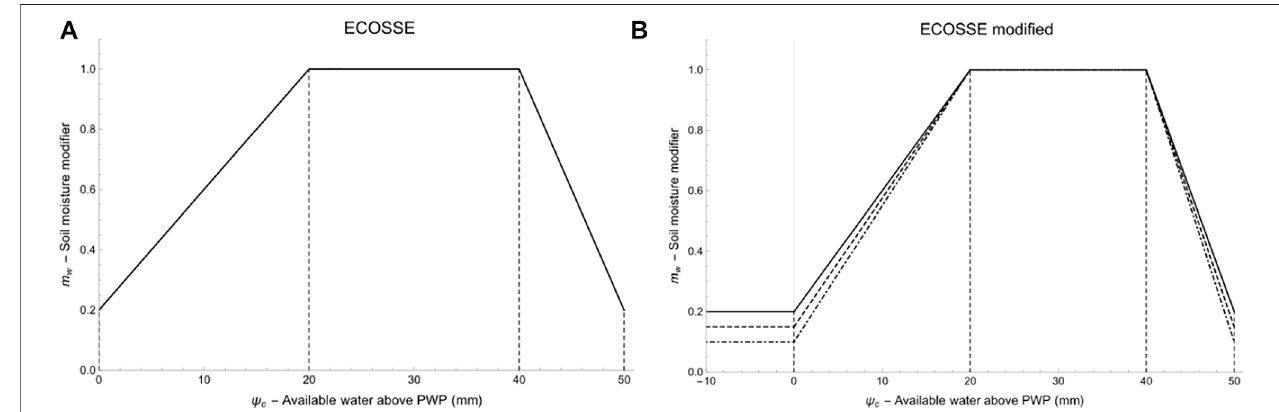
FIGURE2| (A) Soil moisture rate modi fi er for aerobicdecomposition asafunctionofthe available water above permanent wilting point (PWP) in ECOSSE; (B) and in its modi fi ed version – the continuous line refers to normal soil, dashed line to dry soil, and dot-dashed line to semiarid